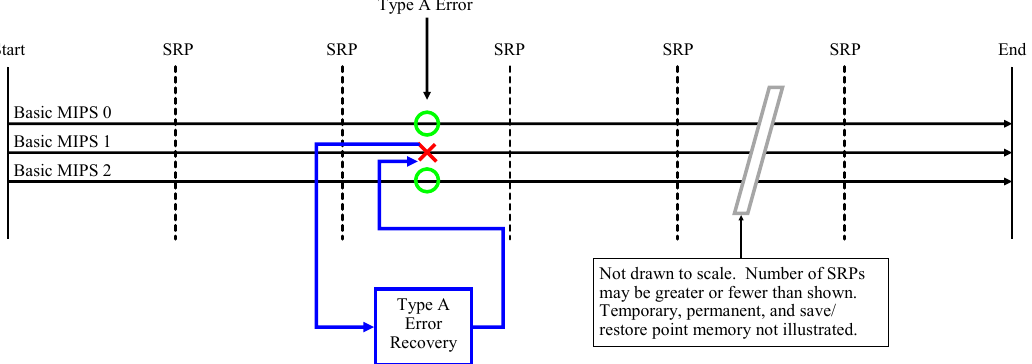
Figure A3. TMR MIPS Type A error timing diagram.